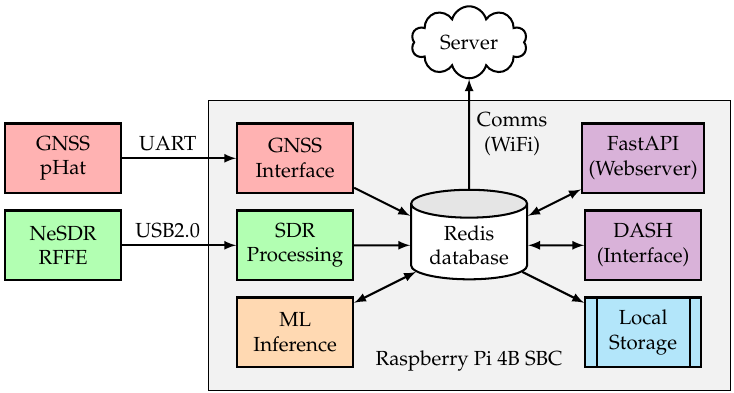
Figure 7. Software flow diagram and